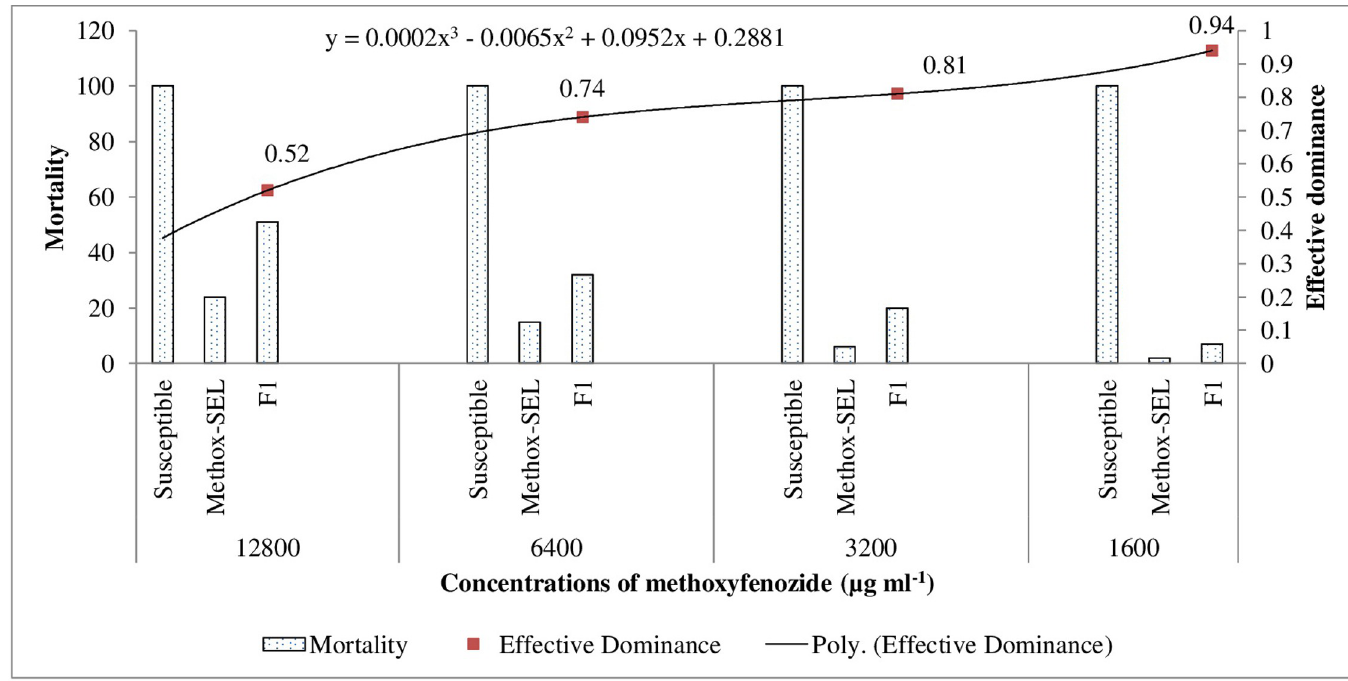
Fig 4. Effective dominance (D ML ) of resistance in Methox-SEL strain of Chrysoperla carnea .